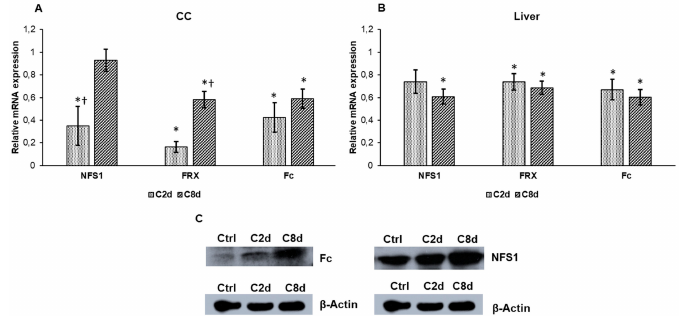
Figure 6. mRNA and protein analyses of NFS1, frataxin (FRX), and ferrochelatase (Fc) genes in CZ treated groups. Real Time PCR was performed with SYBR green protocol using gene specific primers. The relative expression of the controls was regarded as 1. Western blot analyses were done from protein extracts of the liver tissue samples. The same amount of protein (15 µ g) from each sample was loaded onto 10% SDS-PAGE and transferred to nitrocellulose membranes and probed with NFS1 or Fc polyclonal rabbit antibodies. β -actin was used as loading control. ( A ) Relative mRNA expression values of NFS1, FRX, and Fc in CC. ( B ) Relative mRNA levels of NFS1, FRX, and Fc in the liver. ( C ) Protein expression levels of NFS1 and Fc in the liver. The Western blot experiments were repeated at least three times in each group. The bars represent mean values and error bars represent standard errors of the mean (SEM) for three independent measurements. For statistical analyses, Student’s t -test and two-sample t -tests were used. The asterisk marks p < 0.05 compared to non-treated animals, while the cross indicates a di ff erence p < 0.05 between the treated groups, n = 6 in each group. Optical density analyses can be seen in Figure